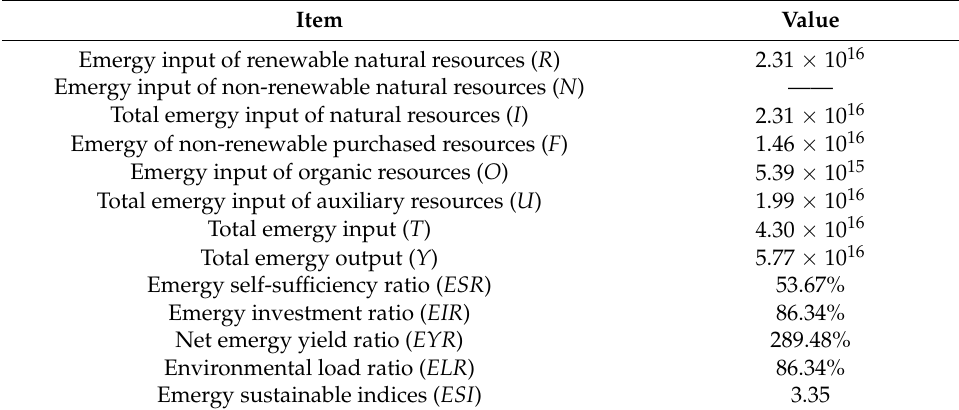
Table 3. Emergy evaluation index calculation of the courtyard unit. Item